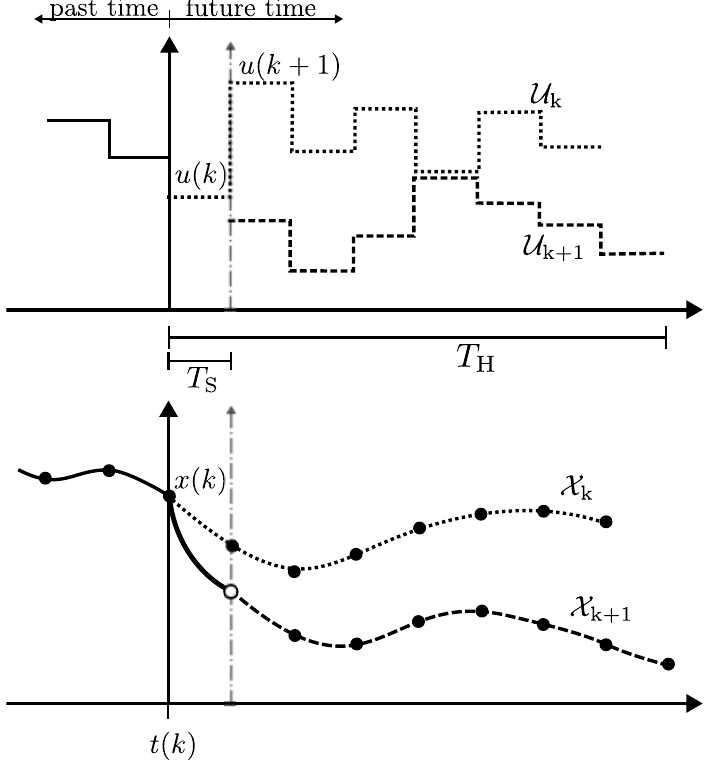
Figure 7. MPC notation and principles. (Top) controller output and (bottom) system states.